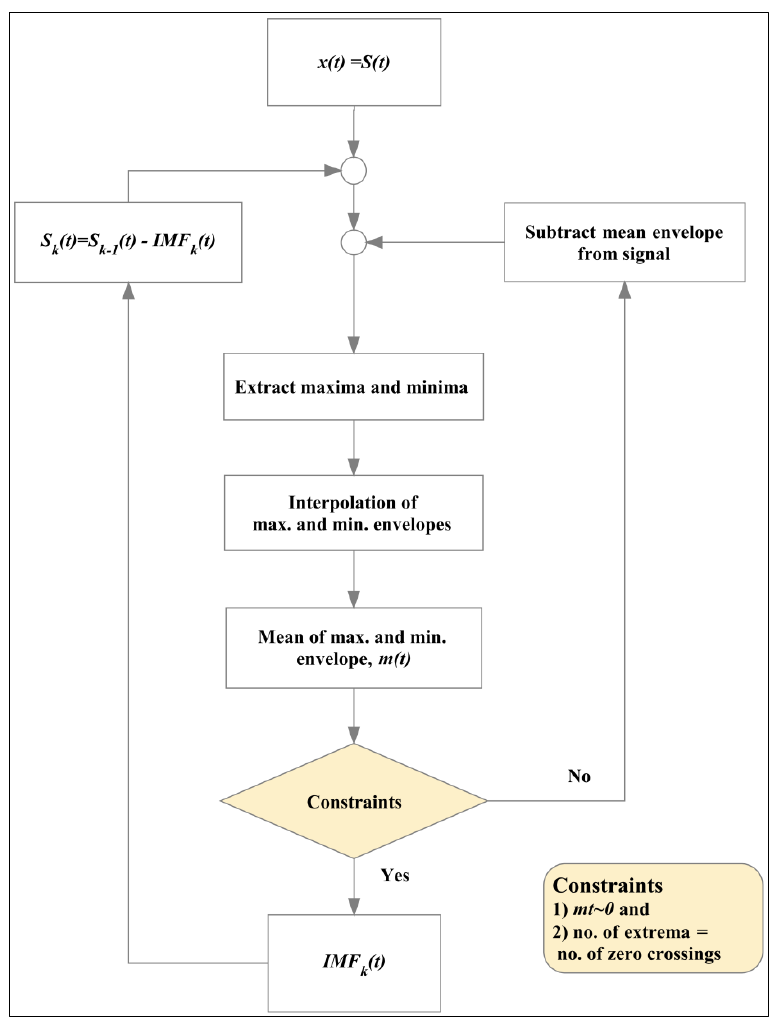
Figure 1. Flowchart of Empirical Mode Decomposition (EMD) in the Hilbert-Huang transform